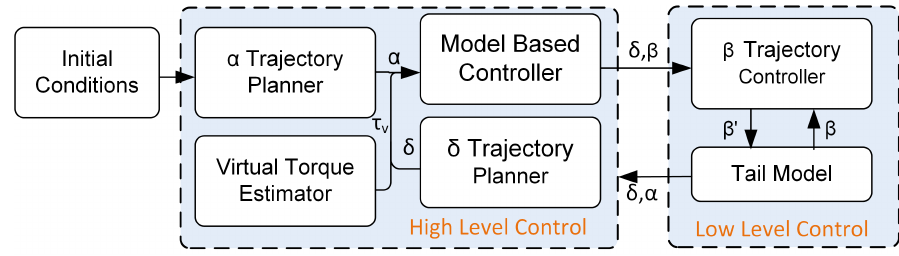
Figure 6. Schematics of the proposed model-based